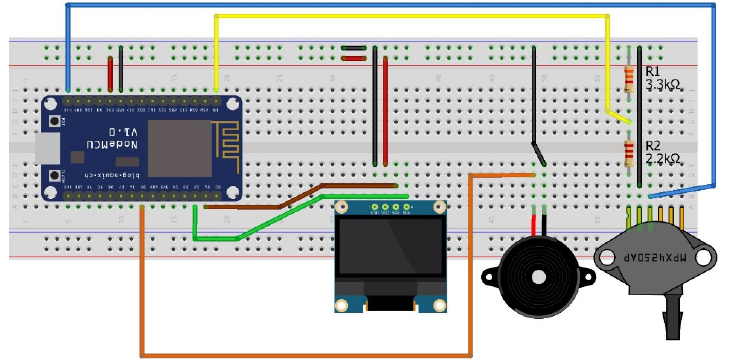
Figure 5. NodeMCU connections.